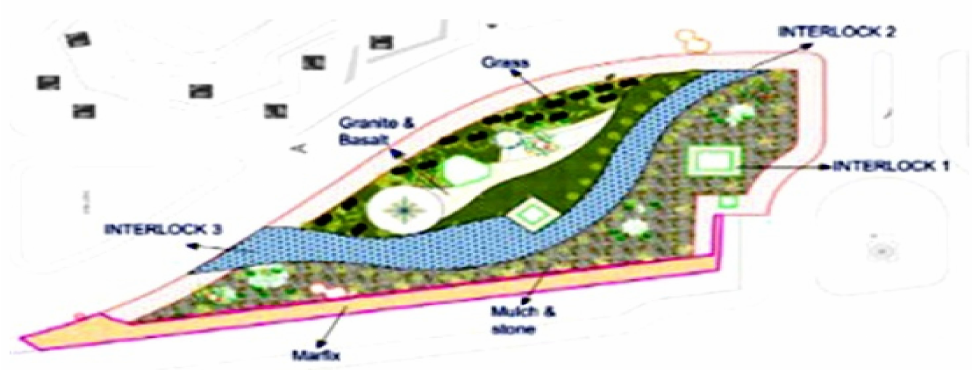
Figure 10. Applying xeriscape for Gate 11 landscape area. Xeriscaping softscape design (Details of water consumption is shown in Table